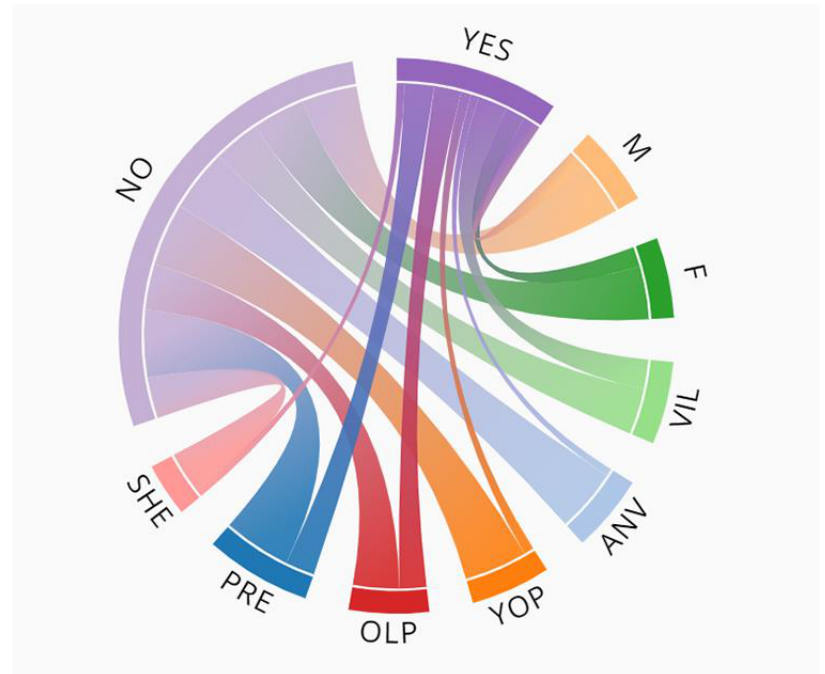
Figure 5. Chord diagram of collection of specimens and sociodemographic characteristics of the 242 people interviewed. M = male, F = female, VIL = born in Villarino de los Aires, ANV = born in an- other village, YOP = young people, OLP = older people, PRE = primary education, SHE = secondary (and higher) education.